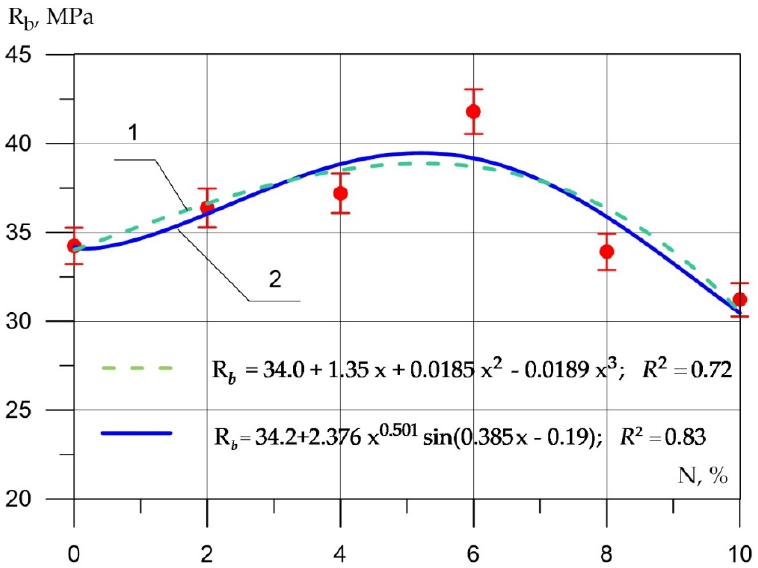
Figure 9. Results of experimental studies of the effect of dosage of rice straw biochar on axial compressive strength: 1—polynomial of the 3rd degree; 2—function (1).